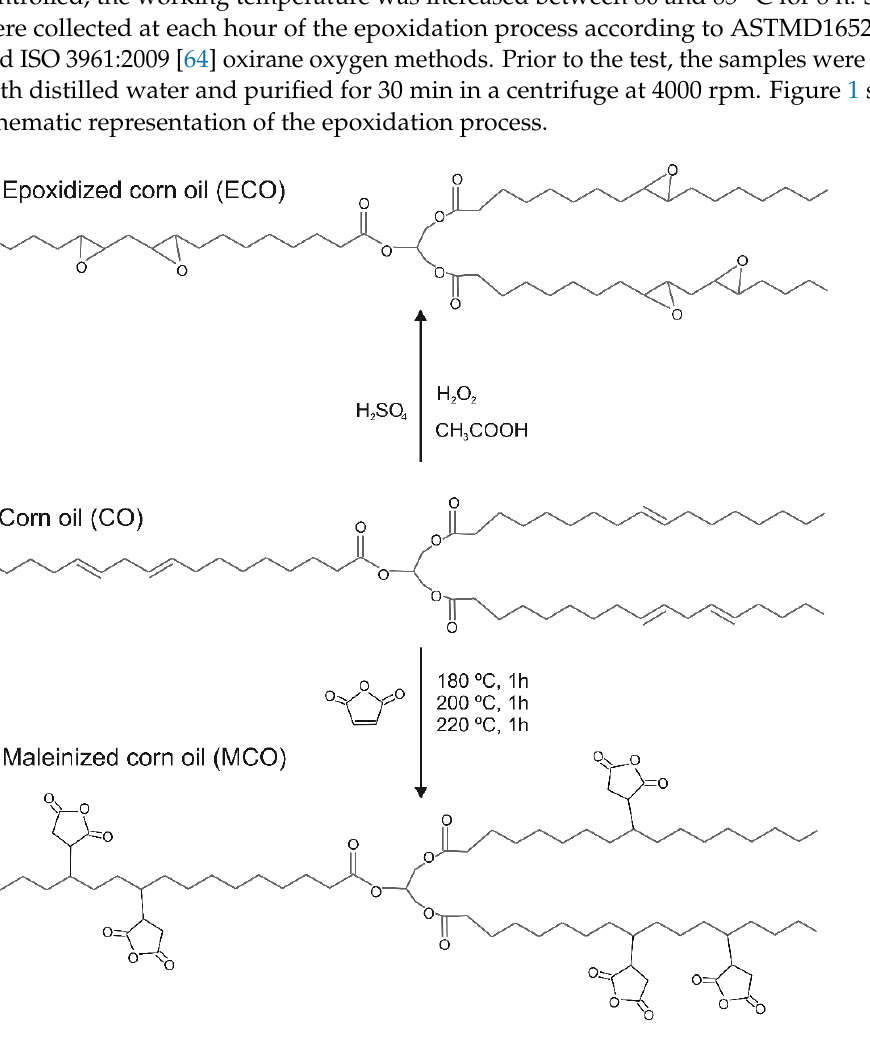
Figure 1. Schematic representation of the corn oil epoxidation and maleinization (MCO) processes.